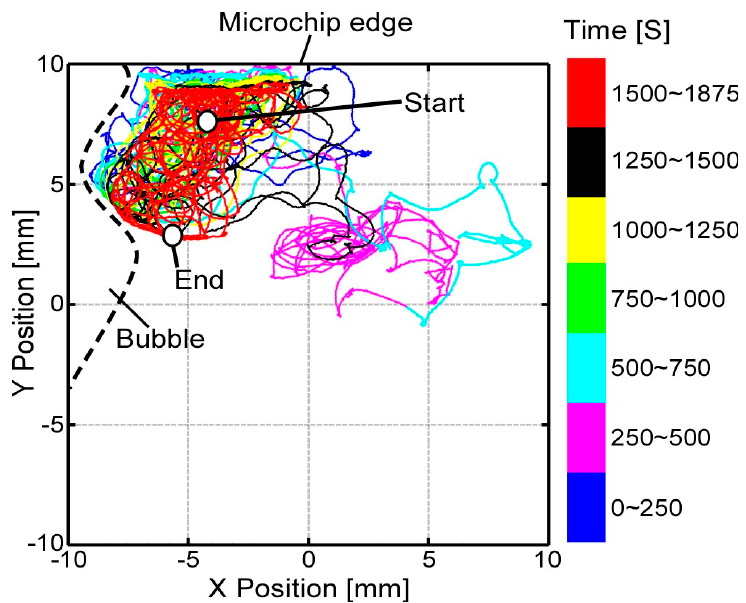
Figure 10. Swimming path of single Paramecium during 31 min and 15 s of target tracking. Maximum swimming speed of the Paramecium was approximately 2 mm/s.